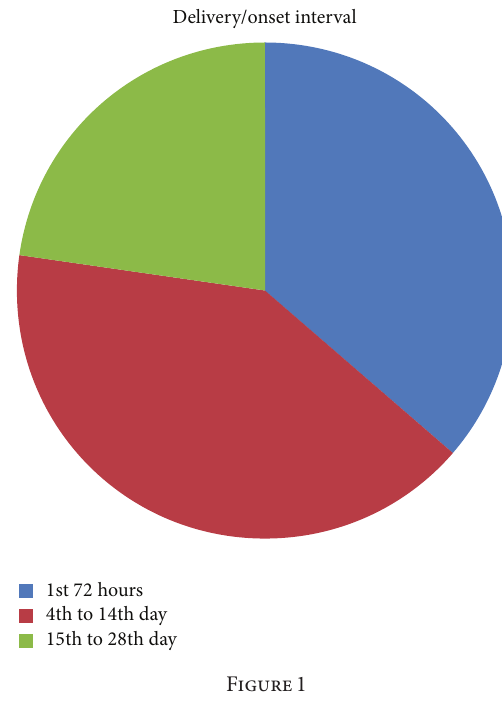
significantly higher risk of postpartum psychosis than women living in the richest